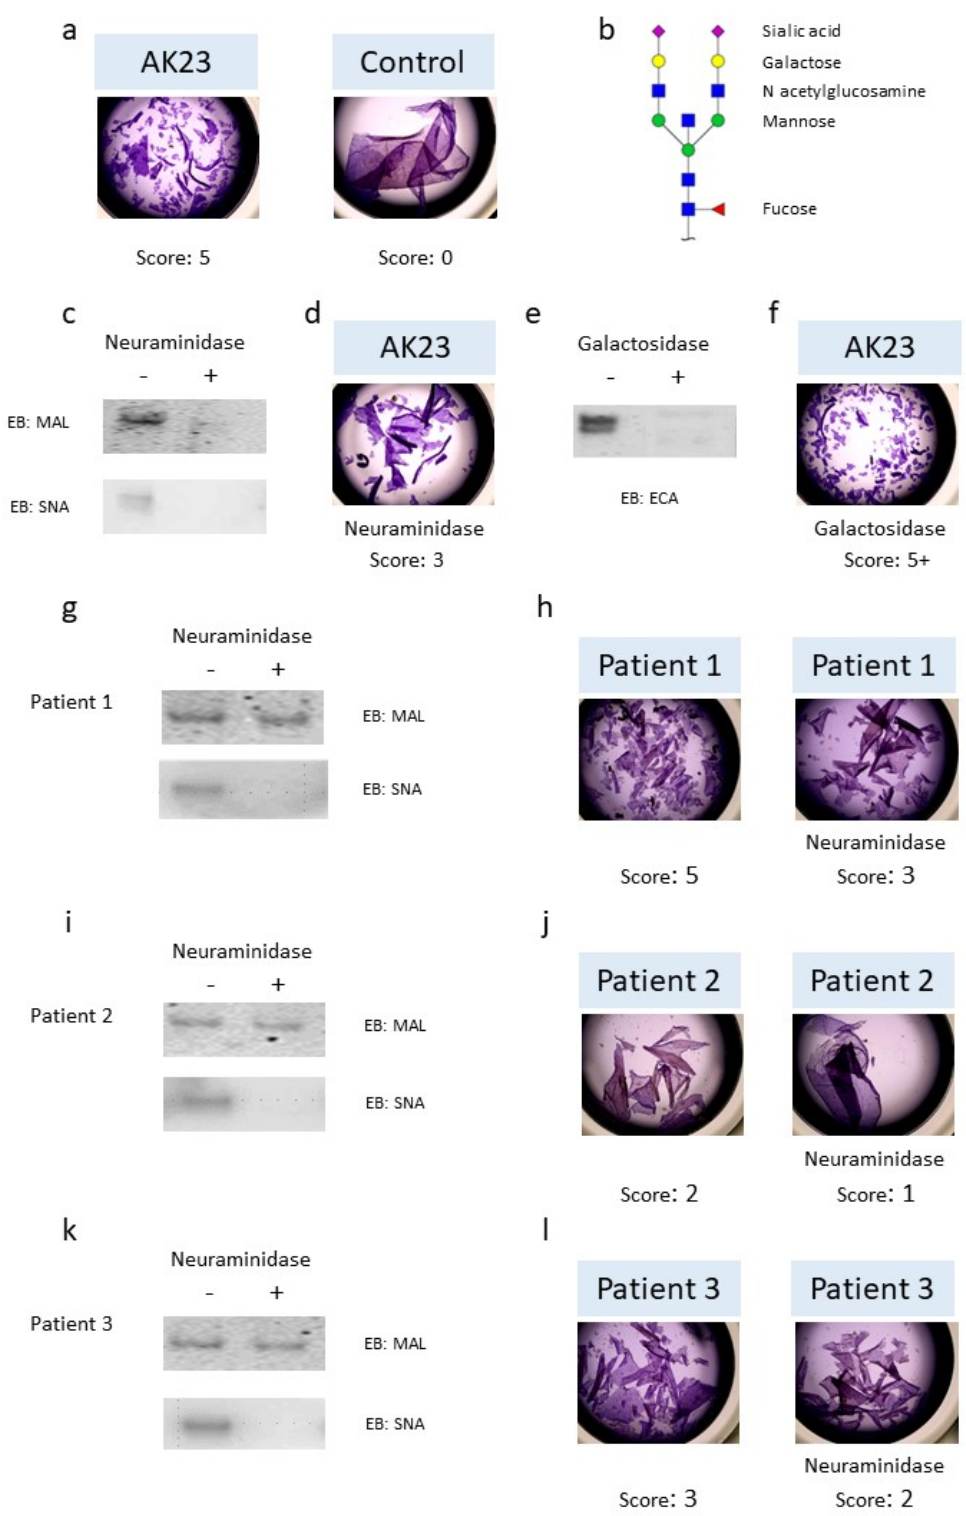
Figure 1. Pathogenicity of monoclonal antibody AK23 and pemphigus patients’ IgG collected during the active phase after the removal of sialic acid and galactose. ( a ) Monolayers of HaCaT cells were treated with monoclonal antibody AK23 (10 µg/mL) or with purified IgG (62.5 µg/mL) from healthy donors for 24 h. Dispase-based dissociation assay and calculation of the score were performed as described in the section 2.6. ( b ) Typical sialylated N -glycan structure on IgG bearing a bisecting N -acetylglucosamine residue. ( c ) AK23 were treated by neuraminidase (+) or not (-) to remove sialic acid and digestion was verified by Eastern blot using Maackia amurensis lectin (MAL II) or Sambucus nigra lectin (SNA). ( d ) Mono- layers of HaCaT cells were treated with AK23 lacking sialic acid (10 µg/mL). ( e ) AK23 were treated with galactosidase (+) or not (-) to remove galactose and digestion was verified by Eastern blot using Erythrina cristagalli lectin (ECA). ( f ) Mono- layers of HaCaT cells were treated with AK23 lacking galactose (10 µg/mL). One experiment representative of three is shown. Patients’ IgG from active phase were treated (+) or not (-) with neuraminidase to remove sialic acid and digestion was verified by Eastern blot (patient 1 in ( g ), patient 2 in ( i ) and patient 3 in ( k )). Monolayers of HaCaT cells were treated with purified IgG collected during the active phase lacking (right) or not (left) sialic acid (62.5 µg/mL) (patient 1 in ( h ), patient 2 in ( j ), patient 3 in ( l )). Pictures were taken with EVOS XL core microscope magnification ×2.